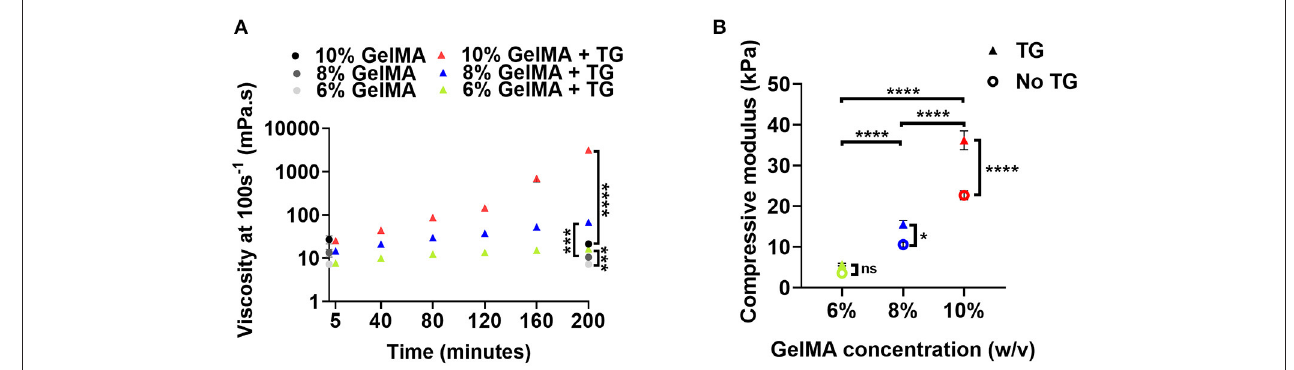
FIGURE 2 | Material properties of GelMA combined with transglutaminase at different substrate concentrations (A) Viscosity at a shear rate of 100 s − 1 of three concentrations of GelMA incubated with transglutaminase at 37 ◦ C. Viscosity is first plotted at 5min, and then at intervals of 40min up to 200min. Data points represent the means of measurements in triplicate with 60 data points averaged for each measurement and error bars show the standard deviation. Controls without transglutaminase are shown at 0min and the final time point only. Significance at 200min was assessed using unpaired t -tests with Bonferroni correction. *** p < 0.001, **** p < 0.0001. (B) Unconfined mechanical compression analysis of GelMA scaffolds at three concentrations, with and without transglutaminase, after overnight incubation at 37 ◦ C plotted as compressive modulus. Data points are means and error bars show standard deviations ( n = 3 or 4). Significance was assessed using a two-way ANOVA with Bonferroni post-hoc test. * p < 0.05, **** p <